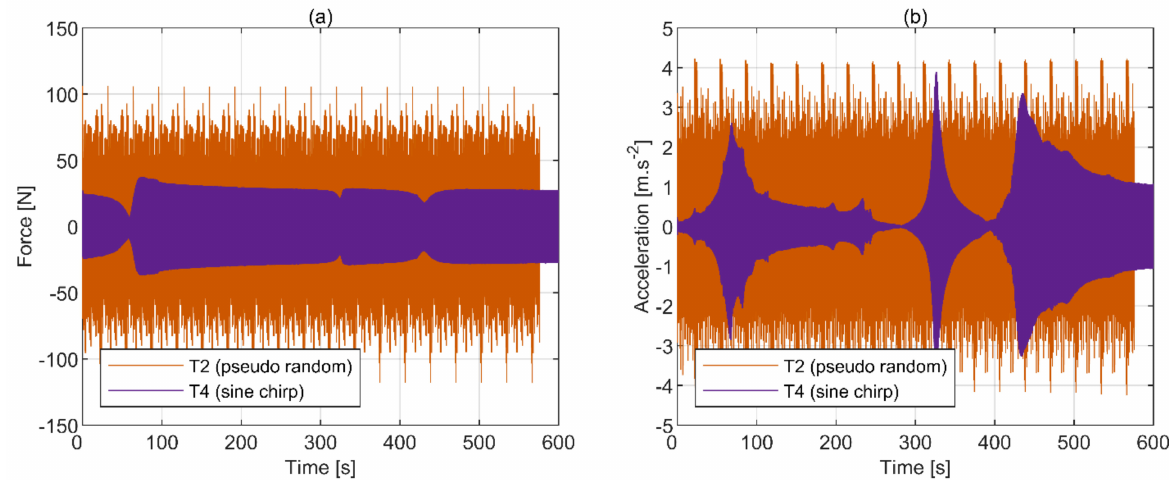
Figure 3. Truncated time histories of ( a ) excitation force and ( b ) structural response at the point of application of force during T2 and